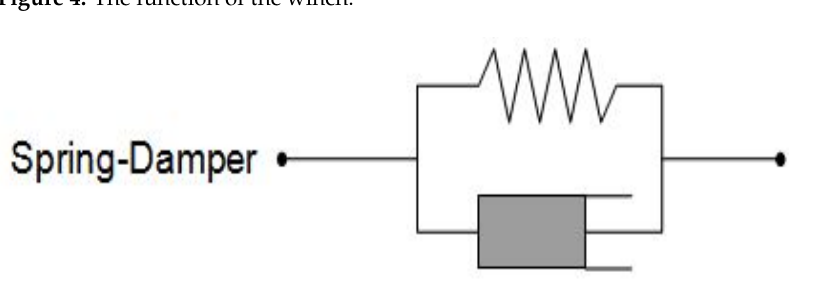
Figure 5. The function of the link.